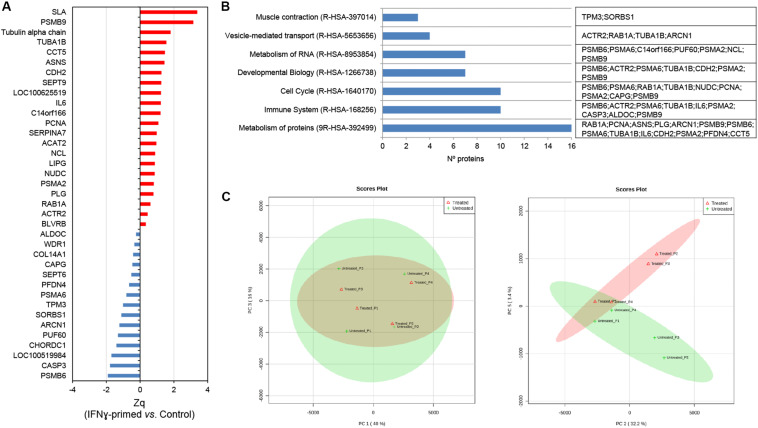
Quantitative proteomic analysis of IFNγ/EV-CDCs. (A) Quantitative proteomic results. Protein profile changes were analyzed by the WSPP model (Navarro et al., 2014) to identify significantly altered proteins comparing IFNγ/EV-CDCs and EV-CDCs samples. Since a combined database (human and pig) for peptide searching was used, data were integrated at the gene coding level. Protein (gene) values (Zq) are reported as the standardized variable, which is defined as the mean corrected log2-ratio expressed in units of standard deviation. The protein ratio of each sample was calculated against an internal standard (IS) based on the average of iTRAQ reporters from EV-CDCs control samples. Statistical differences between Zq values of sample groups were evaluated by paired t-test. Significant protein abundance change was set at a value of p < 0.05. Plots show the integrated Zq values from the sample groups for those proteins significantly up- (red) or down-regulated (blue) in IFNγ/EV-CDCs vs. EV-CDCs. (B) Significantly changed proteins were classified and annotated by Reactome in the top level pathways. (C) A total of 952 proteins (number of peptides, Np ≥ 2 at 1% FDR) quantified by iTRAQ-based proteomics were subjected to PCA. Left: Score plot for PC1 (40% variance explained) vs. PC3 (16% variance explained). Right: Score plot for PC2 (32.2% variance explained) vs. PC5 (3.4% variance explained). Data display 95% confidence regions. Animal origin (n = 4) is indicated on the plots as p1–p4. IFNγ/EV-CDCs (treated) and EV-CDCs (untreated, control) samples are indicated in red and green, respectively.